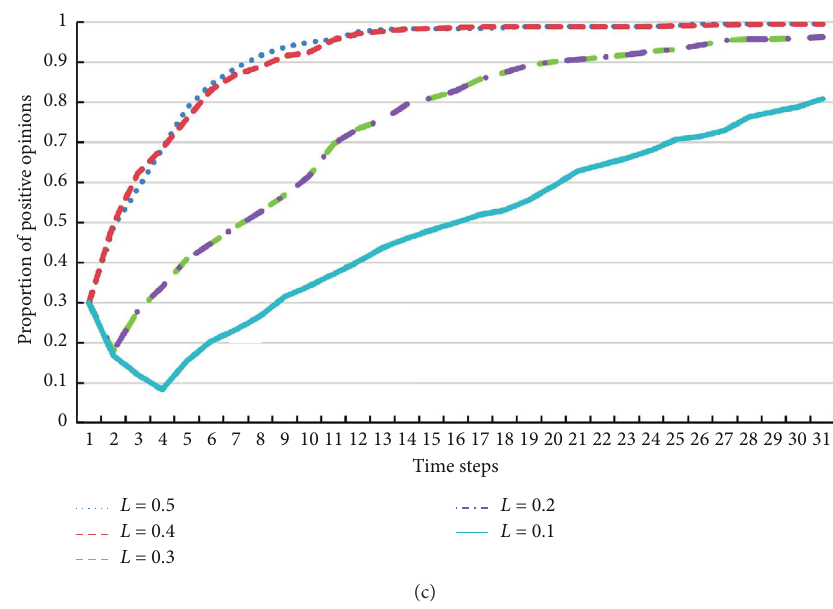
Figure 5: The evolution trends for the initial proportion pp � 0 . 3, opinion control levels k � 1 , 3 , and 5, and L � 0 . 5 , 0 . 4 , 0 . 3 , 0 . 2 , and 0 . 1 in � 20 and m � 5. (a) The initial proportion pp � 0.3, C � 2, and L � 0.5, 0.4, 0.3, 0.2, and 0.1. (b) The initial scale-free networks with m 0 proportion pp � 0.3, C � 6, and L � 0.5, 0.4, 0.3, 0.2, and 0.1. (c) The initial proportion pp � 0.3, C � 10, and L � 0.5, 0.4, 0.3, 0.2, and